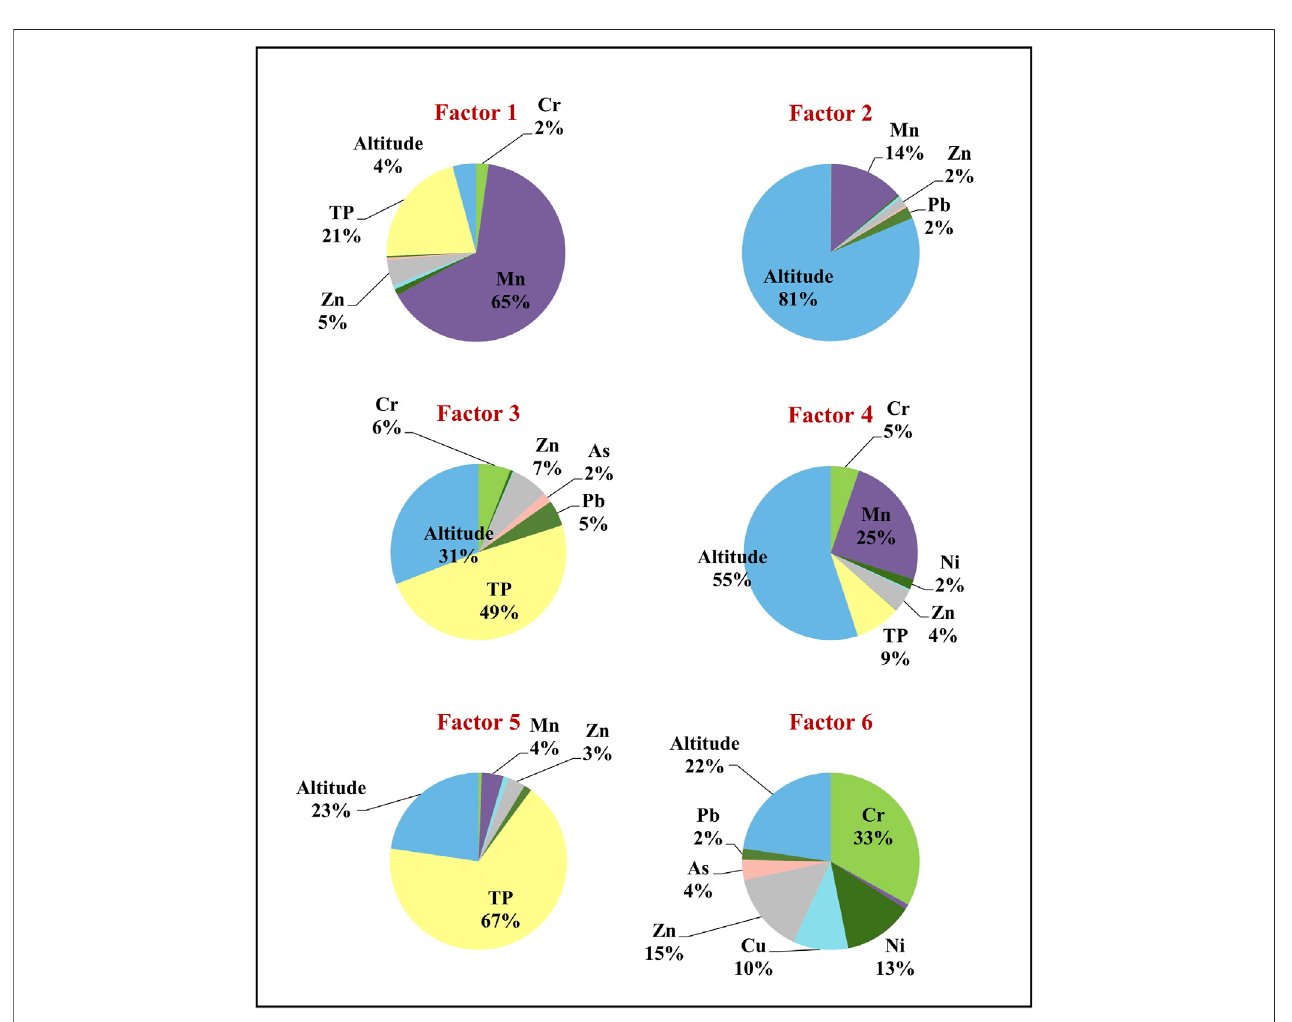
FIGURE 7 | Contribution of heavy metals (% of total